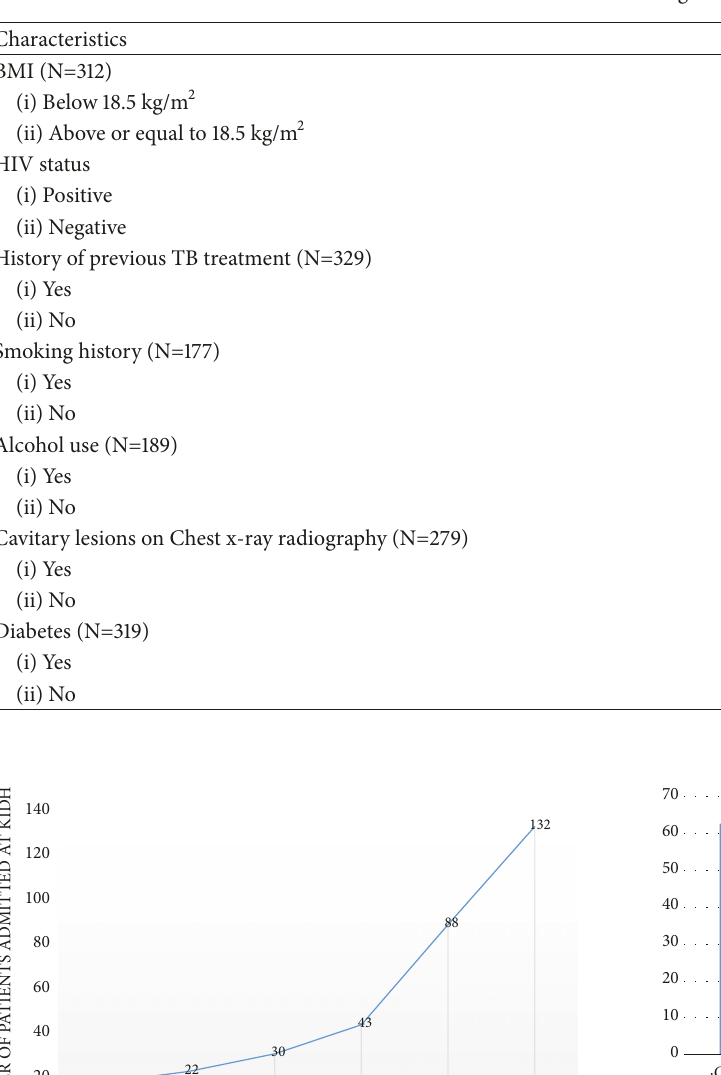
Table 2: Patients’ clinical and radiological features (N=332).